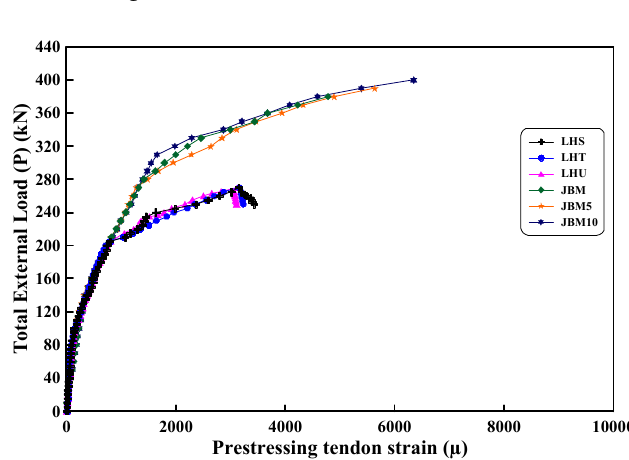
Figure 7. Load ‐ strain curves: Prestressing tendon.